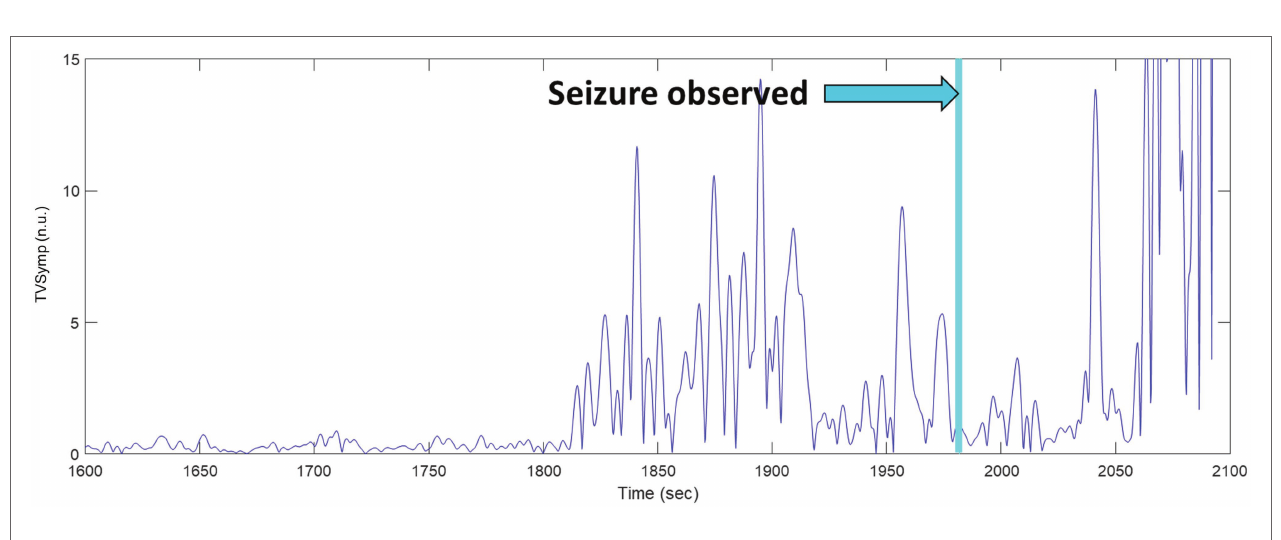
FIGURE 10 | TVSymp elevation before seizure observed in a sample